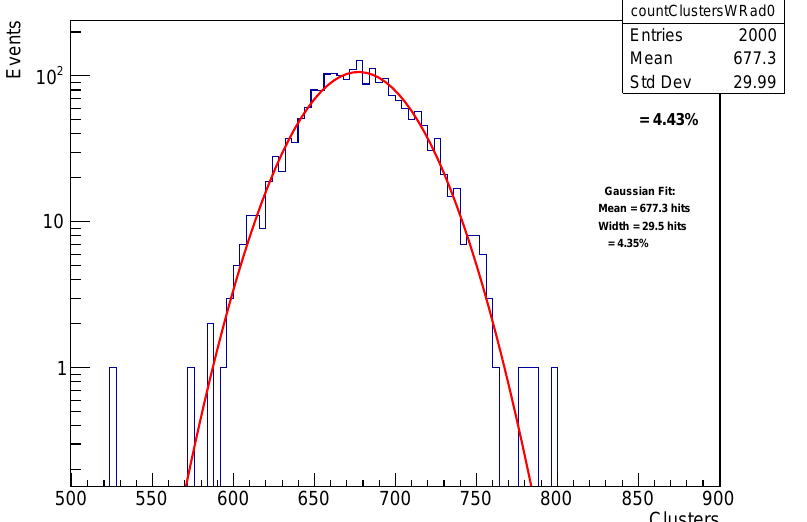
Figure 3. The distribution of weighted (by longitudinal and transverse position in shower) cluster counts for a 10 GeV gamma shower in the new SiD digital MAPs design based on a G EANT 4